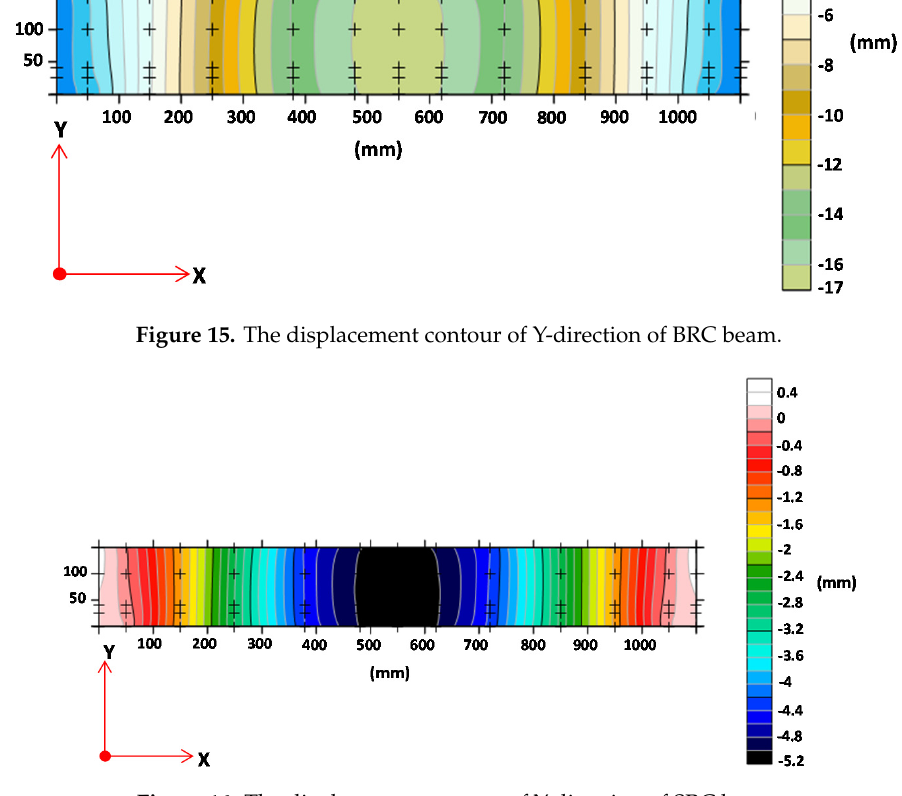
Figure 16. The displacement contour of Y-direction of SRC beam.